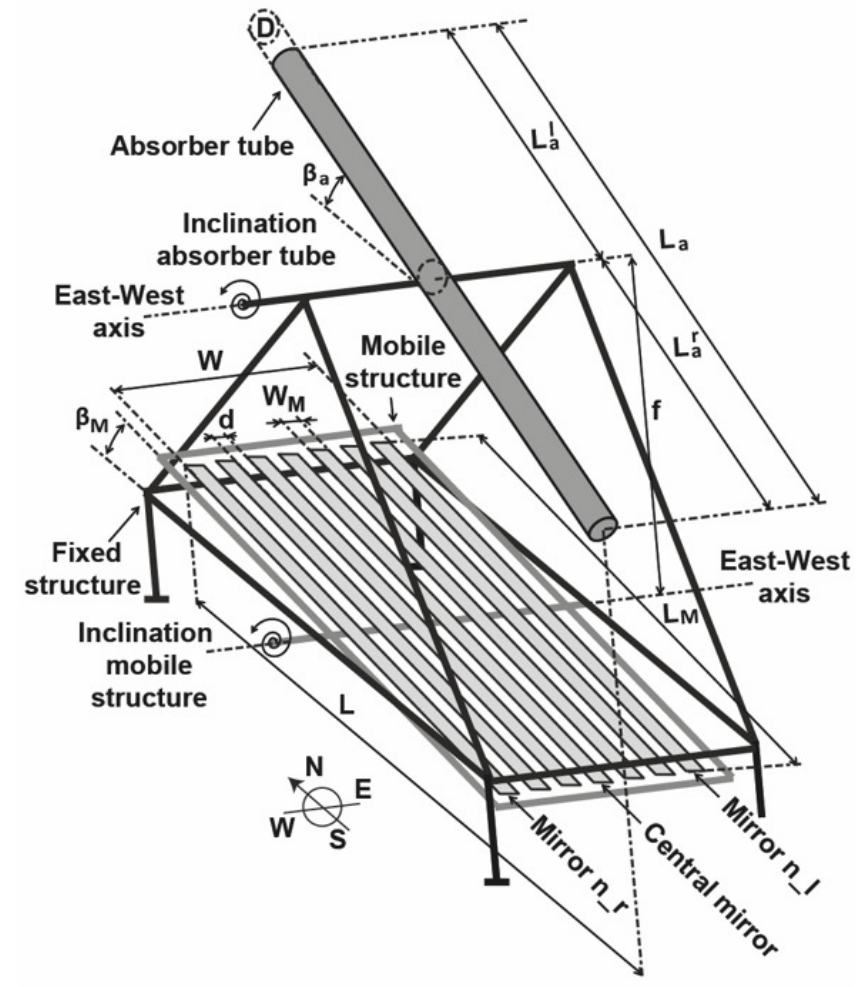
Figure 1. Simplified schematics of a generic SSLFR